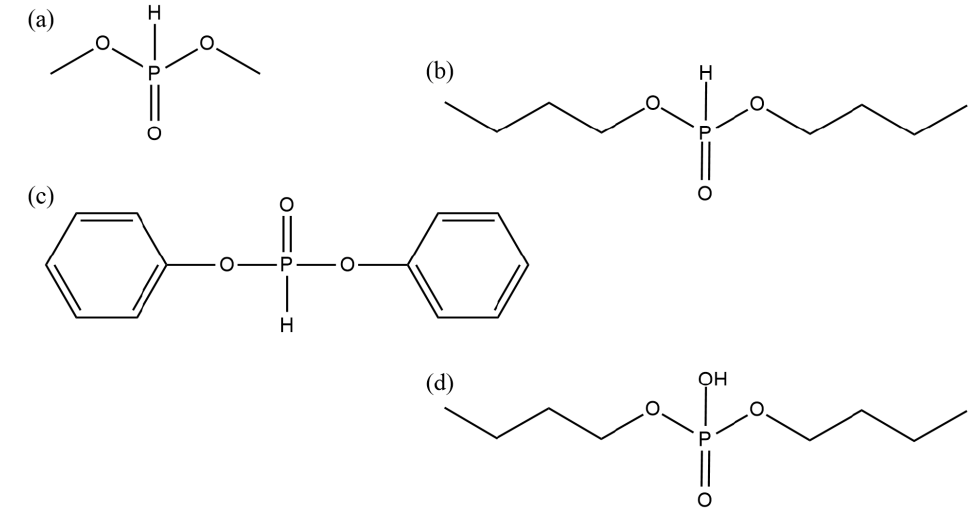
Figure 1. The chemical structures of phosphorus telogens: DMPh ( a ), DBPh ( b ), DPPh ( c ), DBP ( d ). (c) bis(2,4,6-trimethylbenzoyl)-phenylphosphineoxide (APO; Omnirad 819, IGM Resins, Waalwijk, The